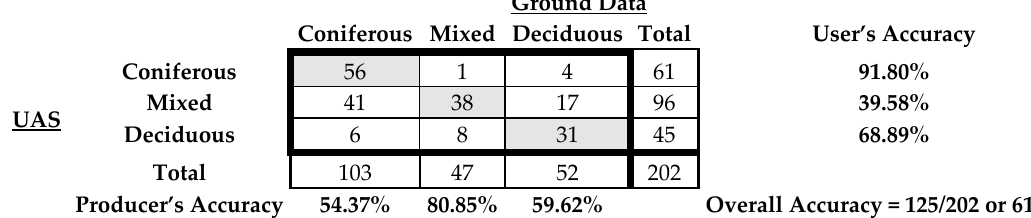
Table 7. CFI plot-registered UAS orthomosaic subsample thematic map error matrix. Ground (reference) data are represented by the CFI plots and Unmanned Aerial Systems (UAS) data are derived from the corresponding orthomosaic.